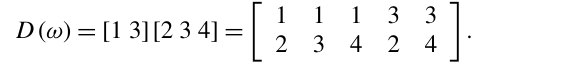
motion ( − m 1 ω 2 ), is marked as edge 1. The same goes for the inertial force of mass m 2 being marked as edge 2. The load of the spring k 1 that is tying the motion of two masses together is marked as edge 3. The load of the spring k 2 tying the mass m 2 to a rigid support surface is marked as edge 4. Last, the external force F 1 acting on the mass m 1 is marked as edge 5. It is important to note that this model and graph is only representing the motion in one dimension.